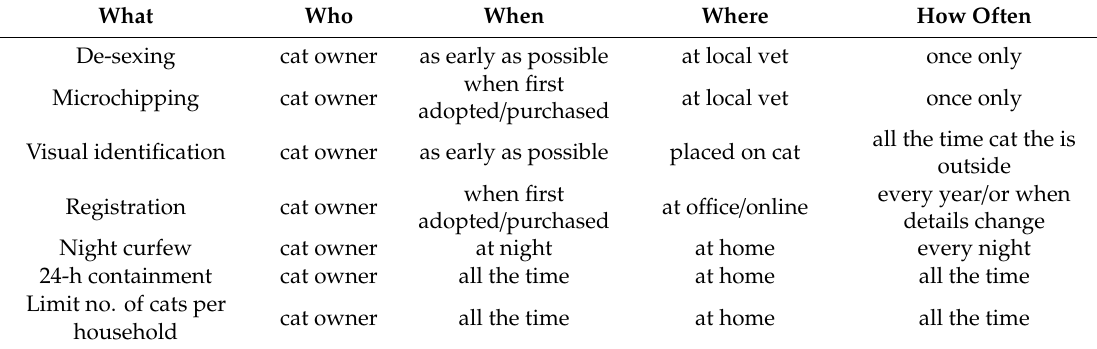
Table1. Listingkeycatownerbehavioursbasedonliterature[19–21]andconsultationwithprofessionals from organisations involved in cat management